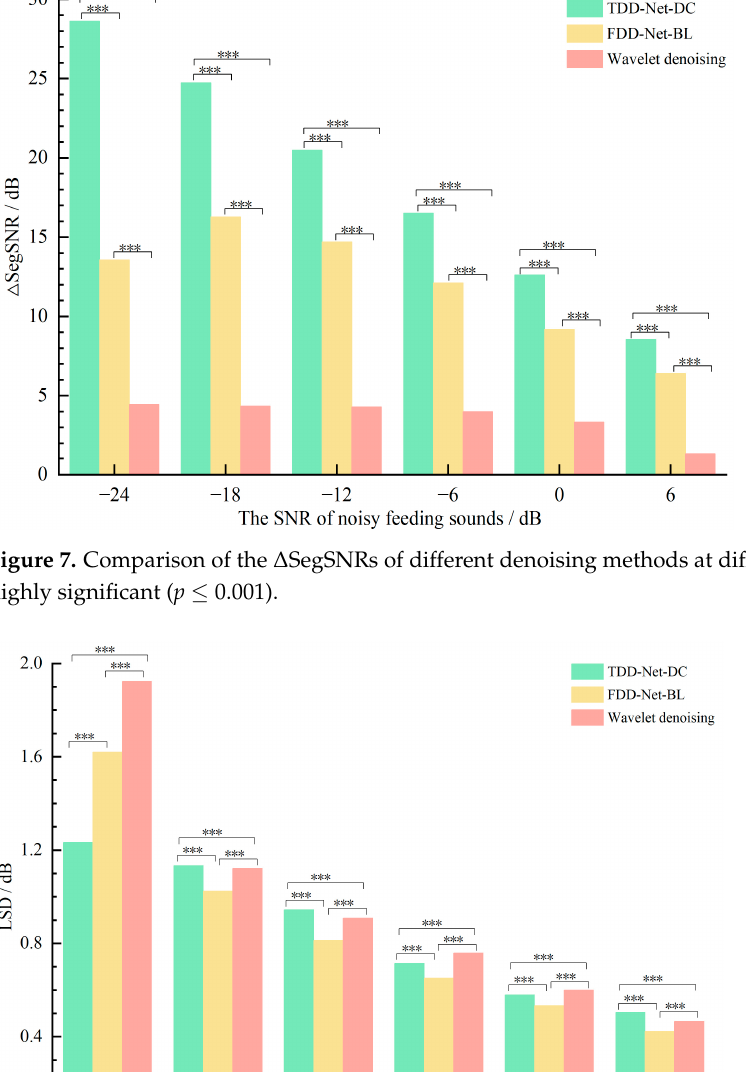
Figure 8. Comparison of the LSD of different denoising methods at different SNRs, *** means highly significant ( p ≤ significant ( p ≤ 0.001).